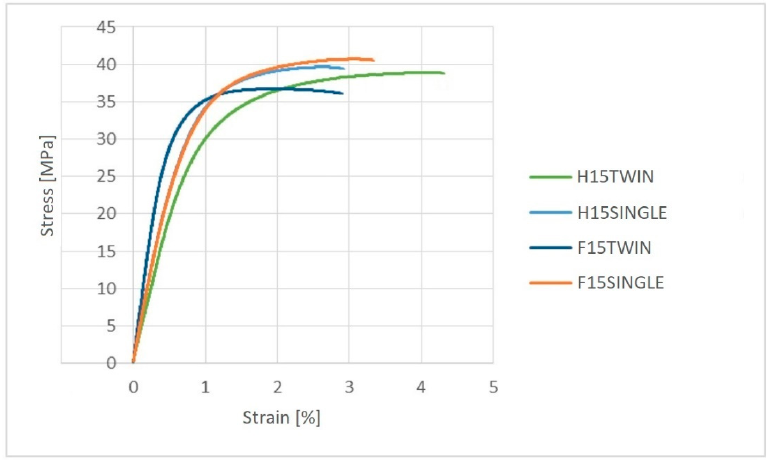
Figure 7. The stress–strain characteristics for PHBV biocomposites produced by single-screw and twin-screw extruders.